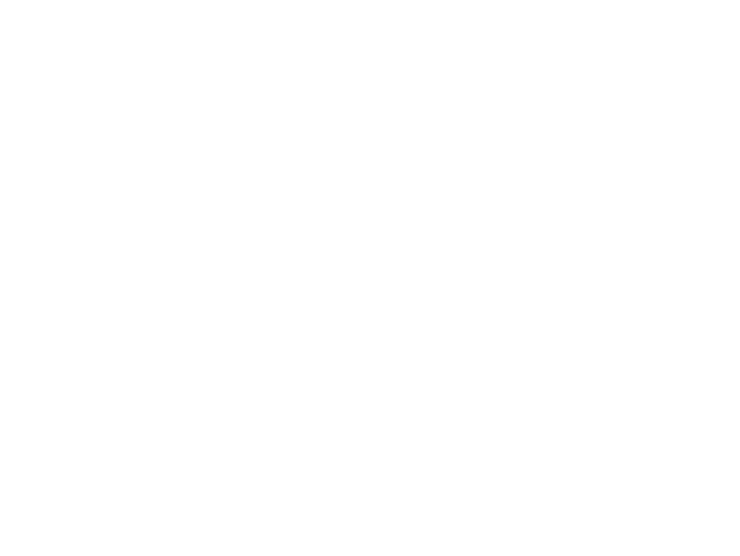
Average GP, R and NP for surface water samples collected during each summer from 2003–2013 at six sample sites from Muskegon River to the Lake Michigan 110 m isobath (error bars represent 1 standard error). Letters (A, B, or C) shown above the bars show metabolic parameters that are statistically different, (P < 0.05 in t-test) and shown in the order of GP–R–NP. Number of samples (n) are also shown above the bars.